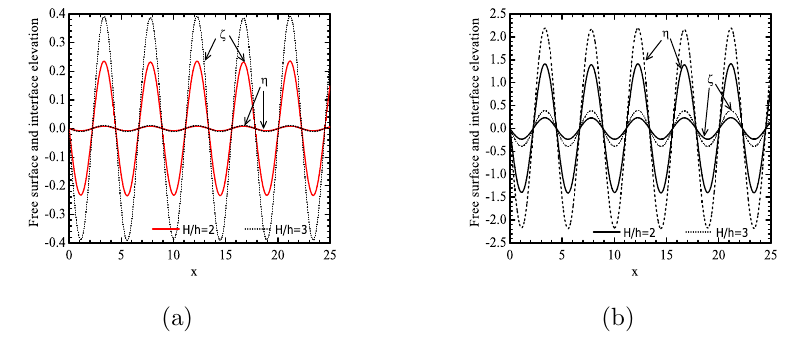
Figure 10. Variation of free surface elevation η and interface elevation ζ for various values of depth ratios H/h : (a) waves with surface mode and (b) waves with interface